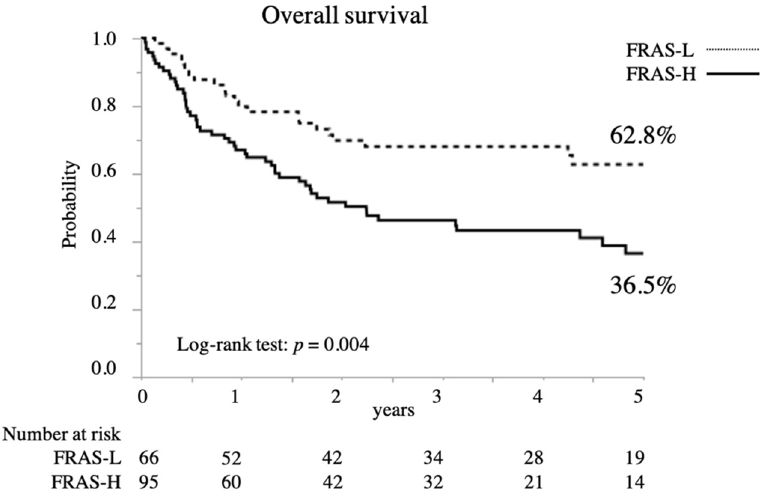
(Table 5). As a result, medical history (HR: 2.71, 95% CI: 1.51–4.86; p < 0.001) and activity